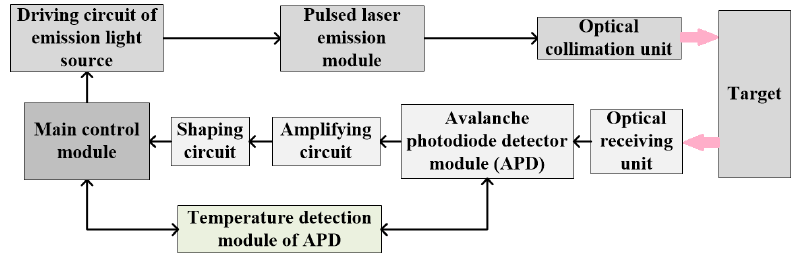
Figure 2. Structure diagram of a short-range pulsed laser ranging system.